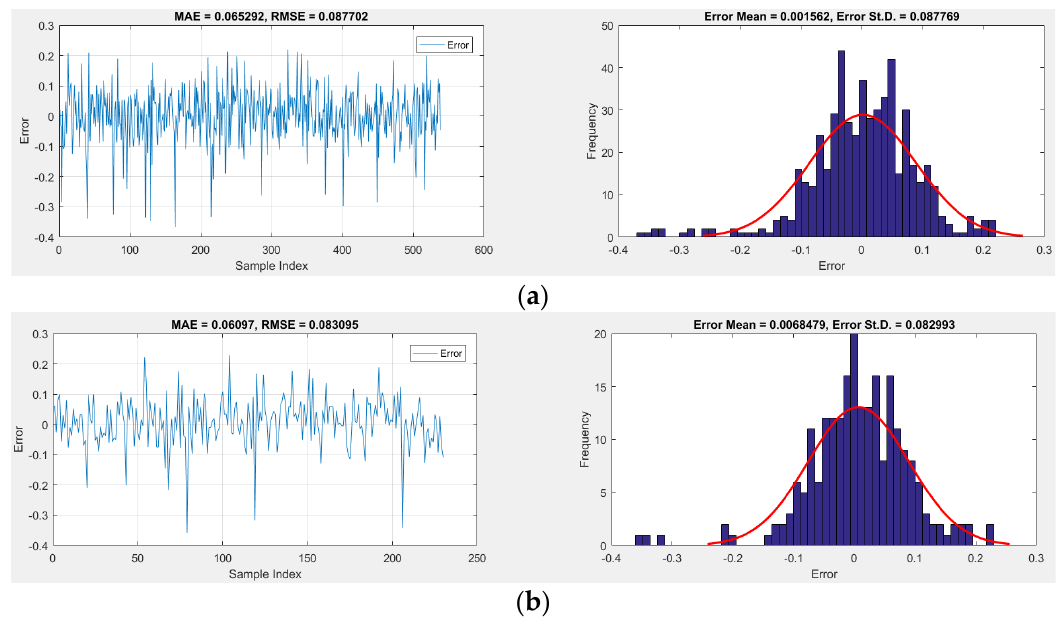
Figure 9. Frequency and minimum value of errors in HHO − ANFIS − 400 best fit structure. ( a ) Train- ing dataset. ( b ) Testing dataset.